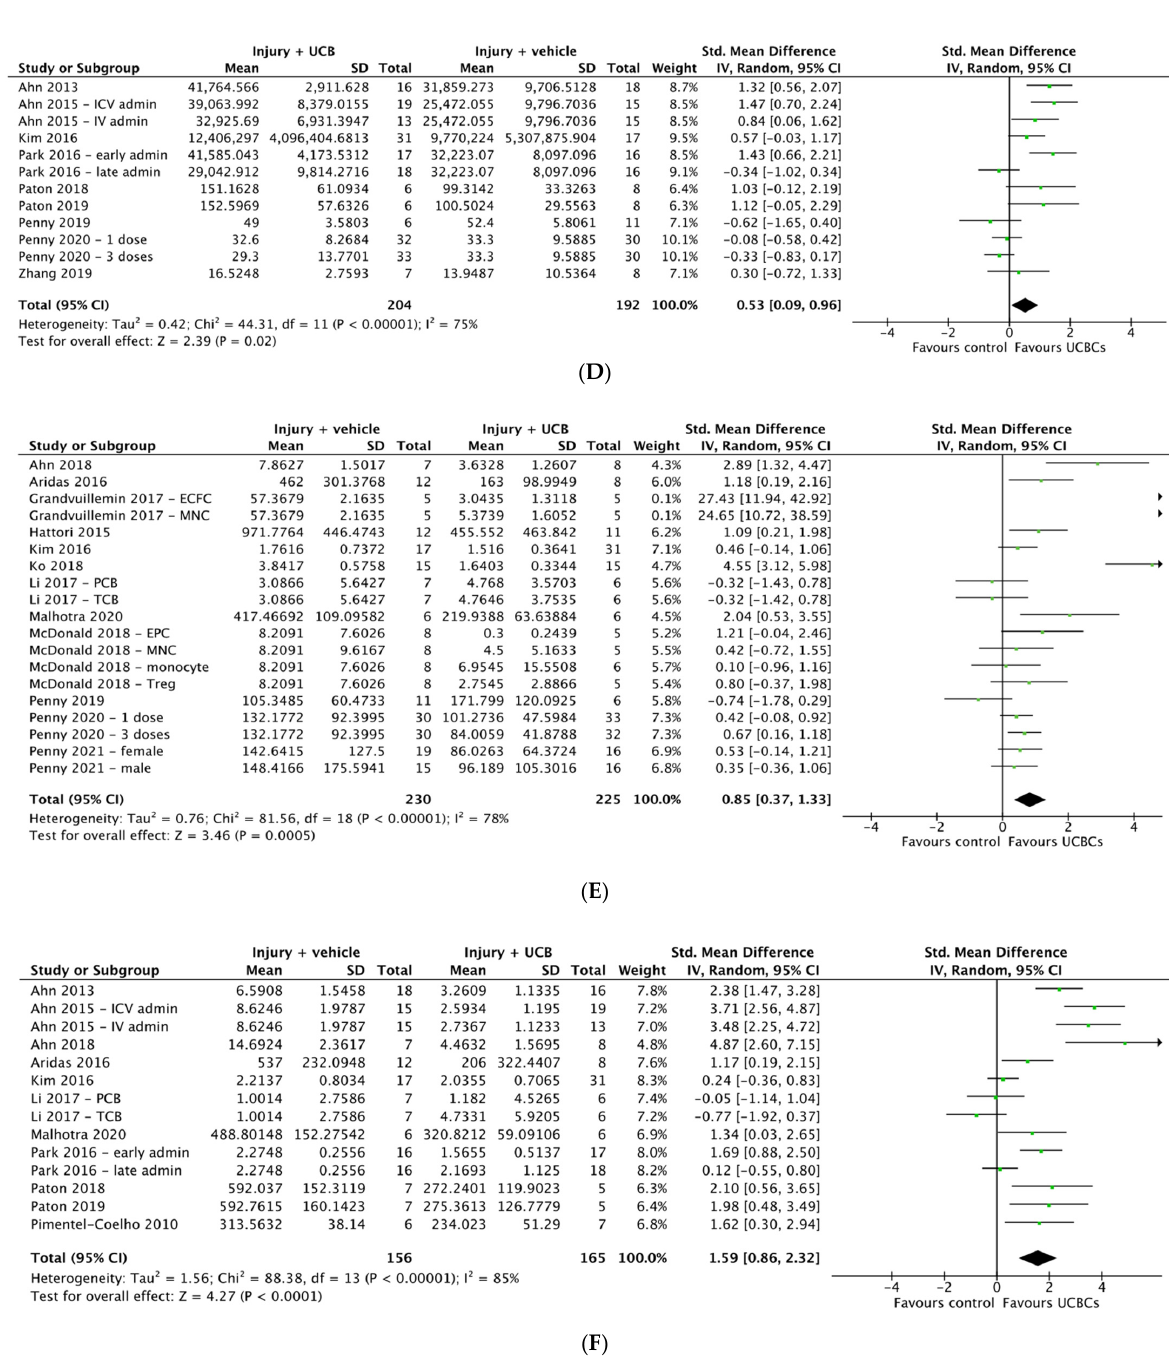
Figure 2. Forest plot demonstrating the effect of umbilical cord blood-derived cell therapy on ( A ) Infarct size; ( B ) Neuron number; ( C ) Oligodendrocyte number—grey matter; ( D ) Oligodendrocyte number—white matter; ( E ) Apoptosis—grey matter; ( F ) Apoptosis—white matter. Umbilical cord blood-derived cell therapy significantly decreased infarct size ( p < 0.00001), increased neuron number ( p < 0.001), increased oligodendrocyte number in both grey matter ( p < 0.0005) and white matter ( p = 0.02), and decreased apoptosis in both grey matter ( p = 0.0005) and white matter ( p < 0.0001). Abbreviations: admin, administration; ECFC, endothelial colony forming cells; EPC, endothelial progenitor cell; HSCs, haemopoietic stem cells; ICV, intracerebroventricular; IV, intravenous; MNC, mononuclear cell; PCB, preterm cord blood; TCB, term cord blood; Treg, T-regulatory cells; UCBC, umbilical cord blood